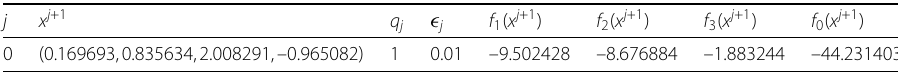
Table 2 Numerical results for Example 4.1 with x 0 = (2,0,3.5,0)